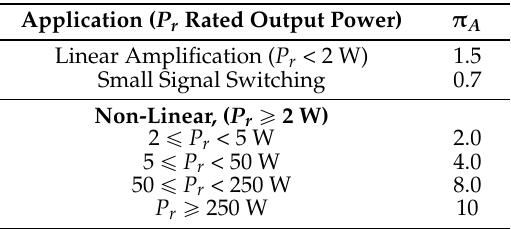
Table 1. Application factor for different rated powers [47,67].